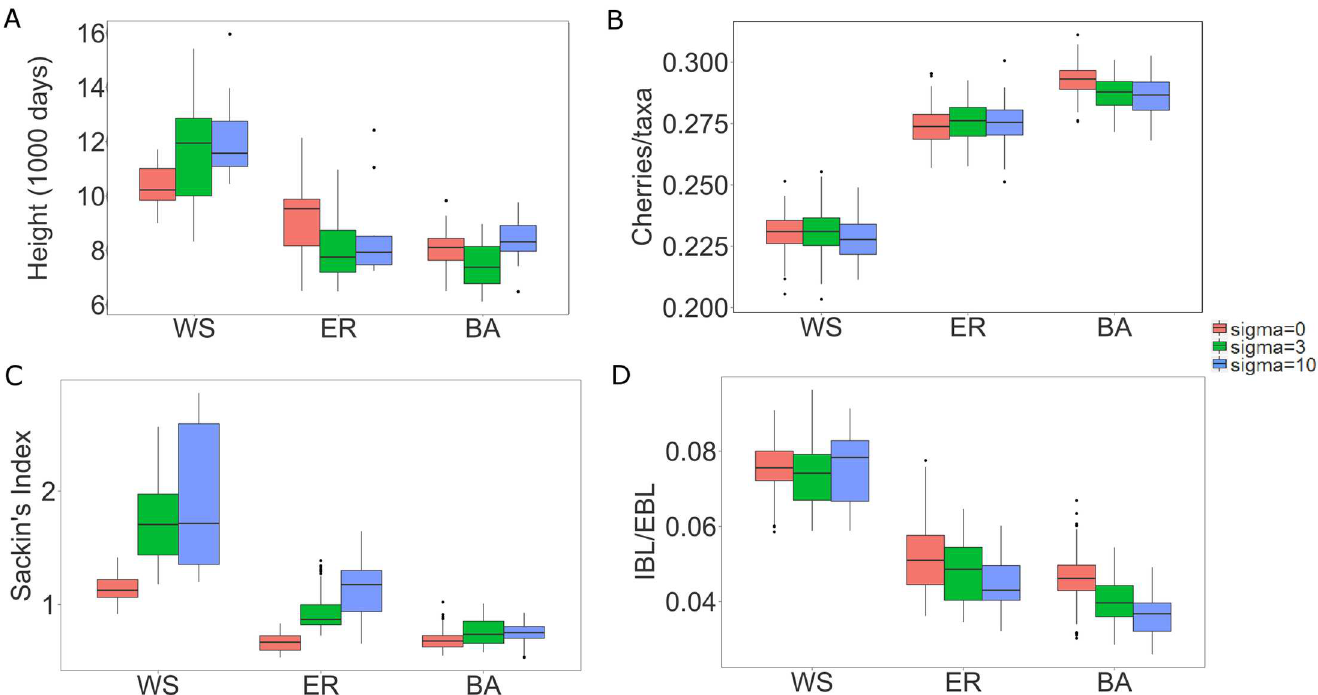
Fig 5. Box plots of tree statistics on virus genealogies for different assumptions on individual heterogeneity. Tree height (A), number of cherries per taxa (B), Sackin’s index (C), mean internal/external branchlengths ratio (D). Box plots limits are as in Fig 3.